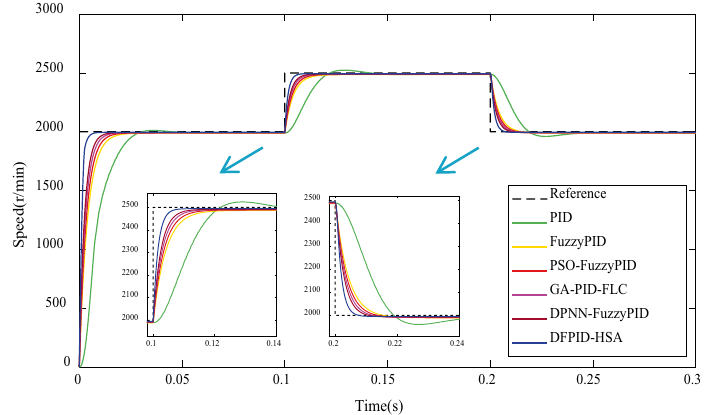
Figure 14. The comparison of speed response under the speed changes condition.